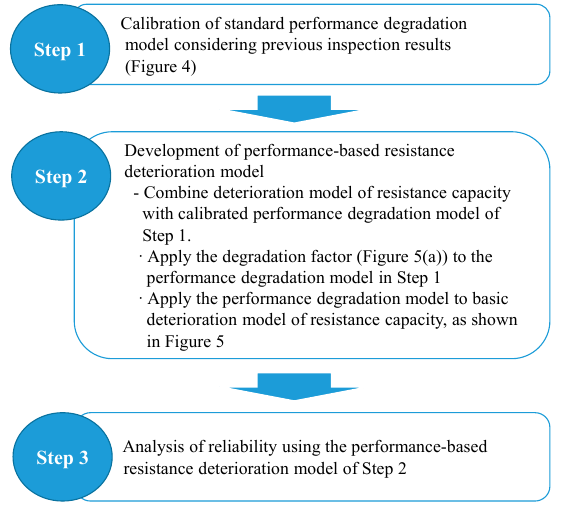
Figure 3. Process of performance-based resistance deterioration modeling.